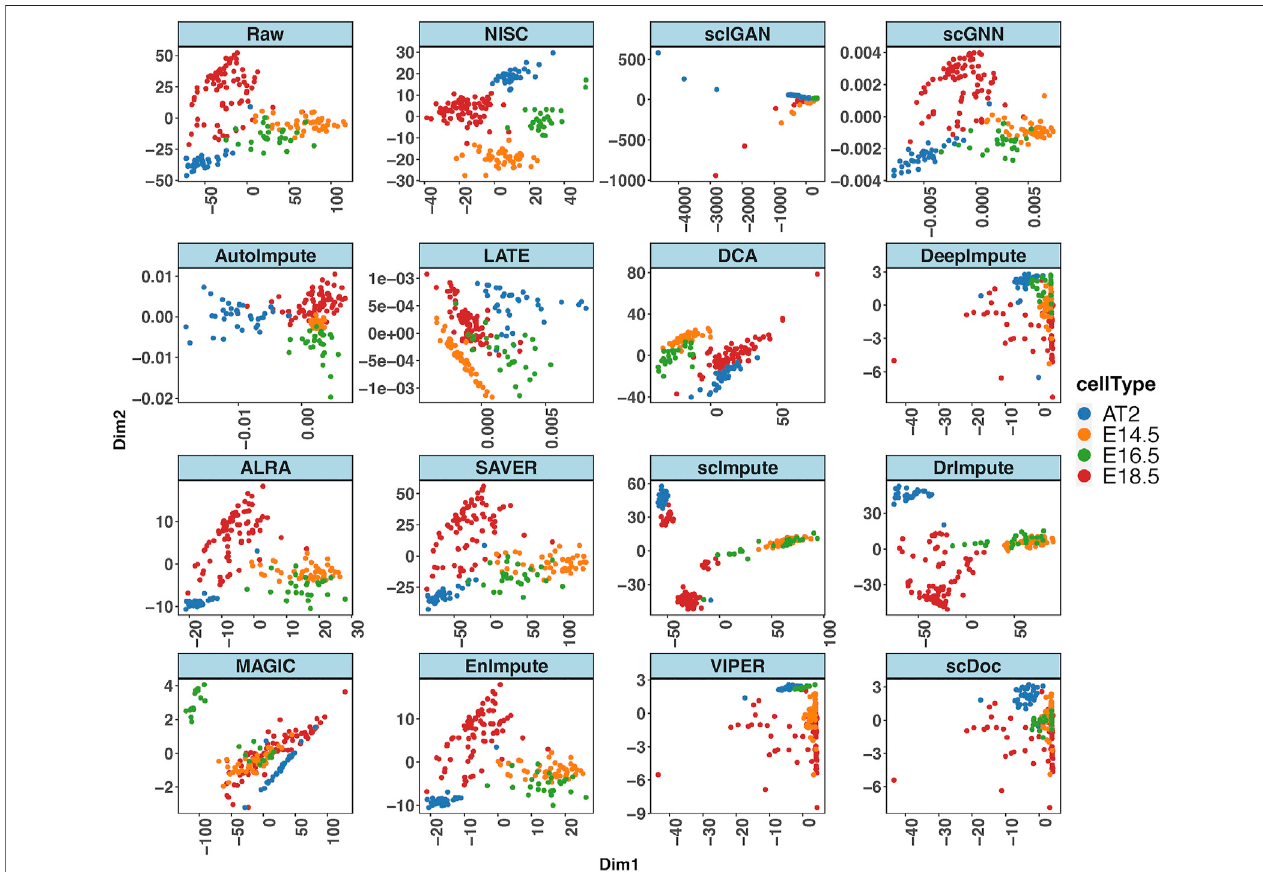
FIGURE 6 | NISC recovers the cell types (E14.5, E16.5, E18.5, and AT2) in mouse lung data. PCA plots of the raw data and imputed data by various imputation methods. The sparsity of the data is 72.6%. Cells are colored by cell types, which are reported in the original